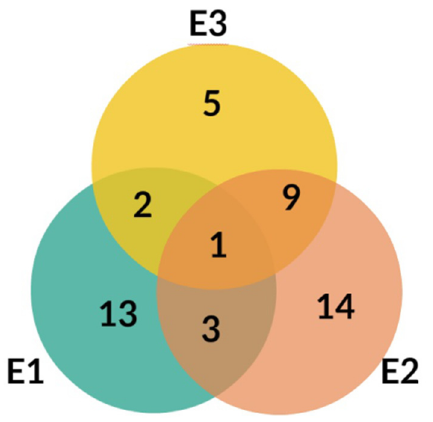
Figure 4. Venn diagram for E1, E2, and E3 extracts from Platycodon grandiflorum A. DC. Table 3. Influence of di ff erent extracts from Platycodon grandiflorum A. DC on VEGF, TGF- β 1, TGF- β